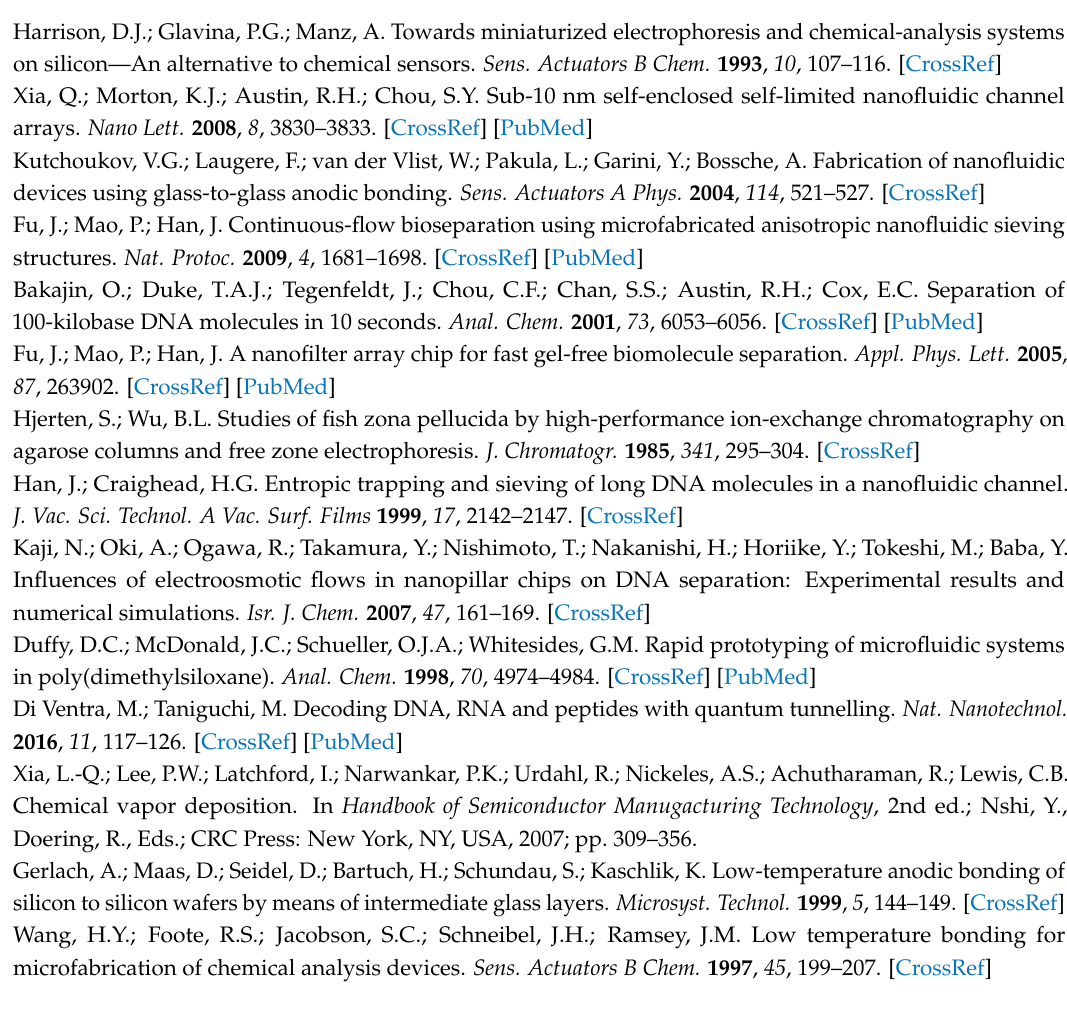
Figure S1: Fabrication process of the nanofluidic devices; Figure S2: Conductivities of TBE buffer preparations with varying concentrations at 25 ◦ C ( n = 12); Figure S3: Monitored time-average currents were plotted as a function of the applied voltage; Figure S4: Monitored time-average currents were plotted as a function of the applied voltage; Figure S5: Monitored time-average currents were plotted as a function of the applied voltage; Figure S6: Monitored time-average currents were plotted as a function of the applied